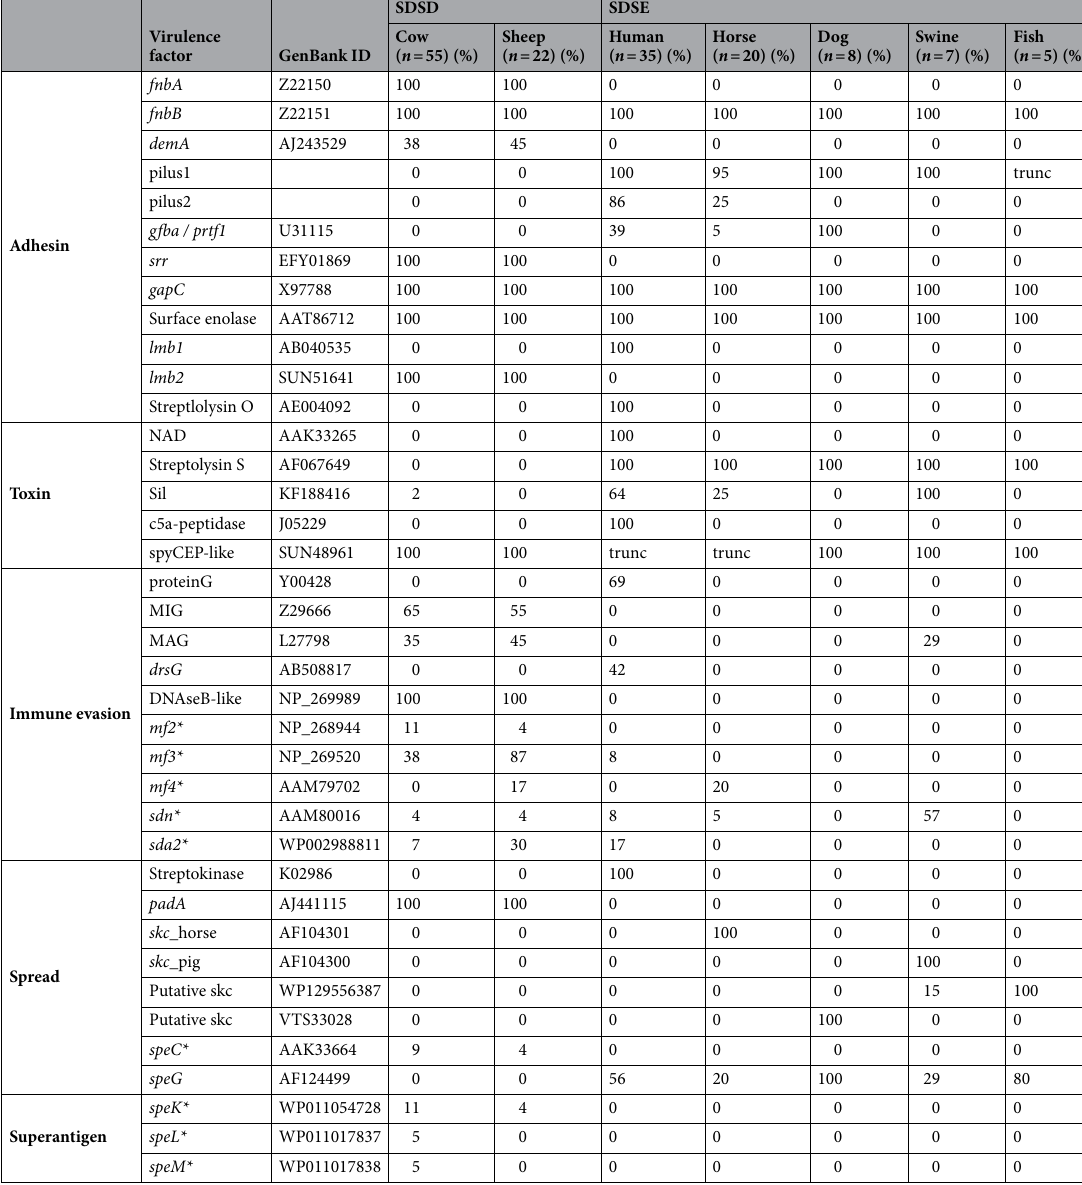
Table 1. Virulence factors of Streptococcus dysgalactiae subsp. dysgalactiae (SDSD) and Streptococcus dysgalactiae subsp. equisimilis (SDSE) . Data presented as percentage of isolates harboring the virulence factor. The four isolates that likely represent cross species transmission have been omitted from the table. Trunc truncated gene, skc streptokinase C. * denotes phage associated genes. No isolates harbored superantigens speA , speH , speI , speJ , speQ , speR , ssa or